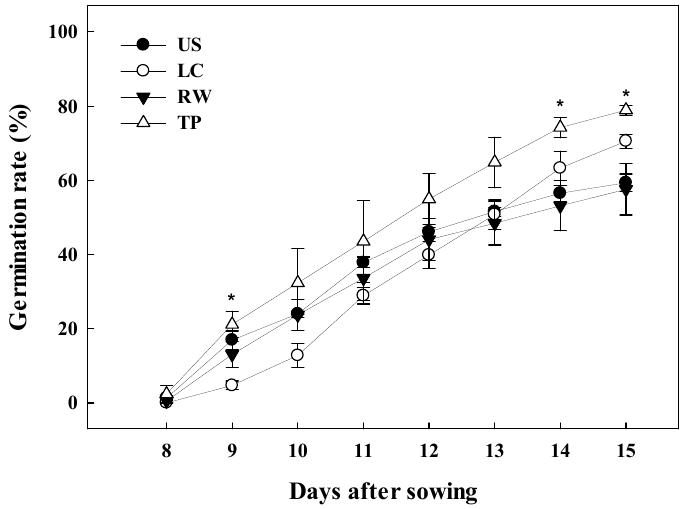
Figure 1. The germination rate of Adenophora triphylla var. japonica Hara as affected by different media. US, urethane sponges; LC, LC grow foam; RW, rockwool; and TP, terra-plugs. Vertical bars represent standard deviation from the mean (n = 3). * Significant at p ≤